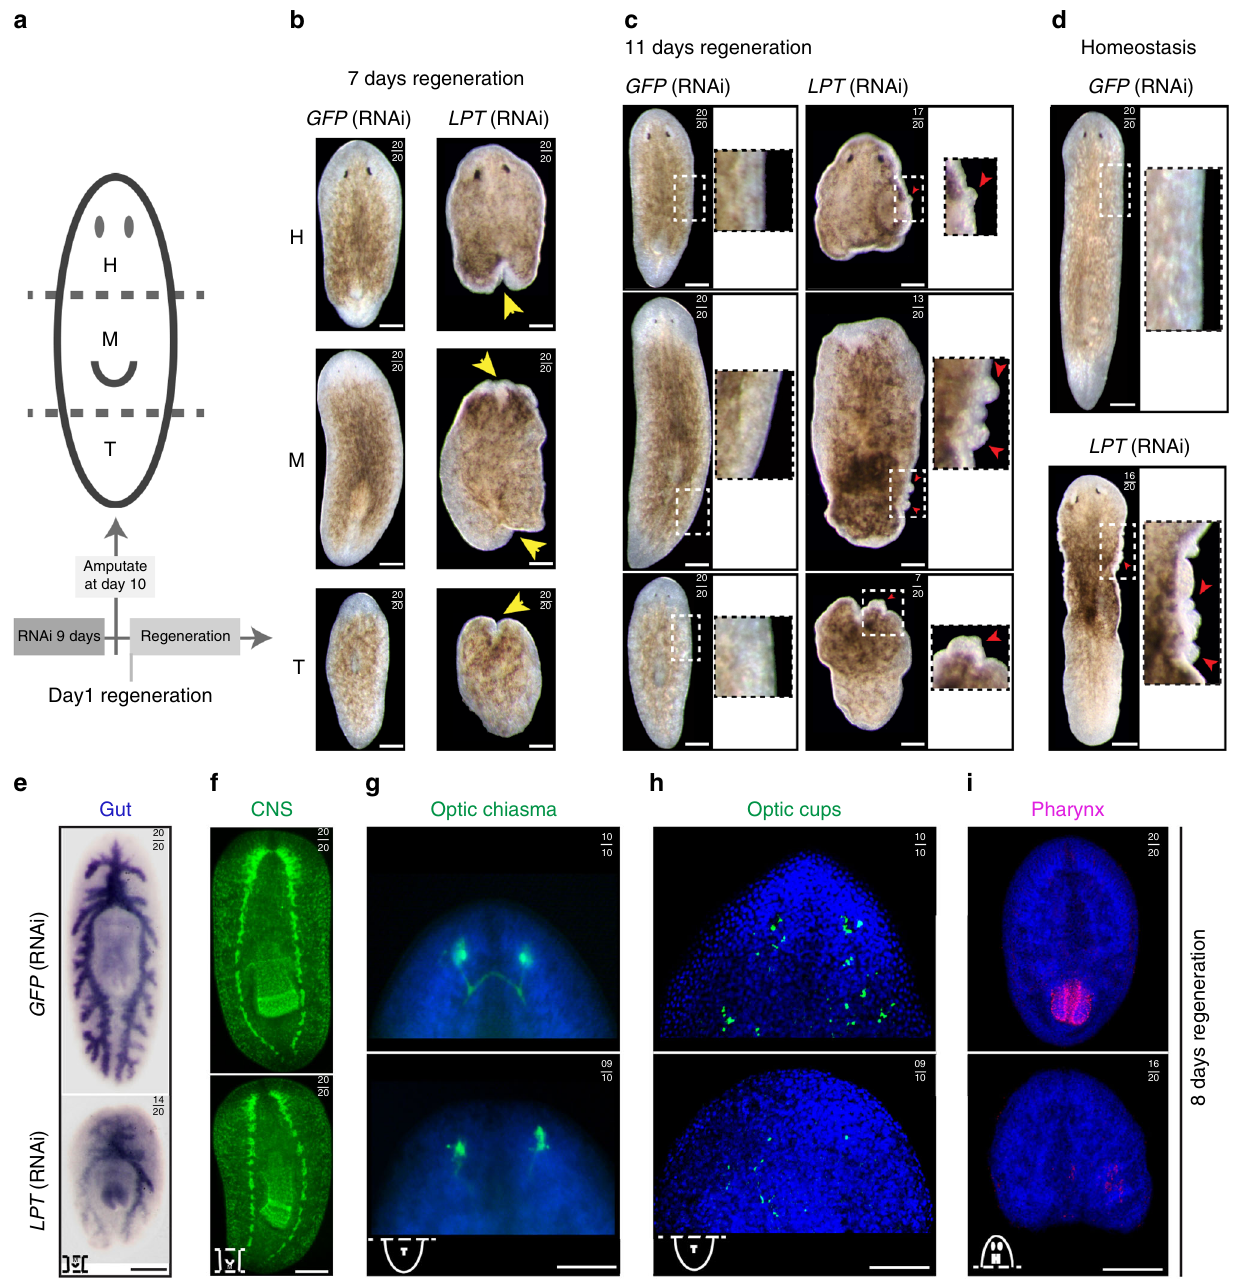
Fig. 2 LPT (RNAi) results in differentiation defects and outgrowth formation during regeneration. a A schematic showing the amputation of RNAi worms into head (H), middle (M) and tail (T) pieces in order to observe regeneration of different structures. The time-course of all the experiments on Mll3/4 knockdown animals is depicted underneath the worm schematic. A total of 9 days of dsRNA microinjection-mediated RNAi was followed by amputation on the 10 th day and subsequent observation of regeneration. b Head, middle and tail pieces following LPT (RNAi) or control GFP (RNAi) at day 7 of regeneration. Yellow arrows point towards the defects in blastema formation. c Head, middle and tail pieces following LPT (RNAi) or control GFP (RNAi) at day 11 of regeneration. Red arrows point towards outgrowths. d Homeostatic animals following LPT (RNAi) or control GFP (RNAi) at day 14 post RNAi. Red arrows point towards outgrowths. e Gut regeneration and maintenance in middle pieces following LPT (RNAi), as illustrated by RNA probe for the gene porcupine-1 at 8 days of regeneration. f Brain regeneration in middle pieces at 8 days post-amputation following LPT (RNAi), as illustrated by anti-SYNORF-1 antibody labeling the central nervous system (CNS). g Optic chiasm recovery in tail pieces at 8 days of regeneration following LPT (RNAi), as shown by anti-VC-1 antibody. h Recovery of optic cups and organized trail of optic cup precursor cells in tail pieces at 8 days of regeneration following LPT (RNAi), as demonstrated by RNA probe for SP6-9 . i Pharynx recovery in head pieces at 8 days of regeneration following LPT (RNAi), as illustrated by RNA probe for laminin . Number of animals with observable phenotype are recorded out of the total number of animals in the top right of each panel. Scale bars: 200 μ